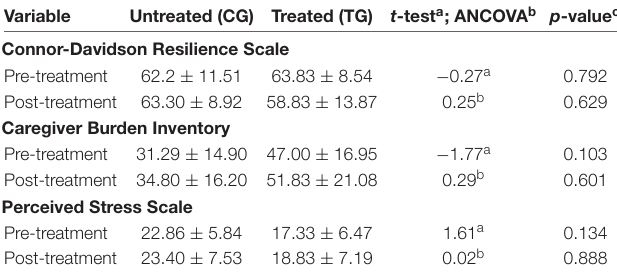
t-test was used for comparing the Untreated and Treated groups on pre- treatment measures; Analysis of Covariance (ANCOVA) was used for comparing the Untreated (CG) and Treated groups (TG) on post-treatment measures, using the pre-treatment ones as covariates. a Marks the results of the “ χ 2 test” and b of the t-test. c Bonferroni corrected alpha level of 0.05/6 =